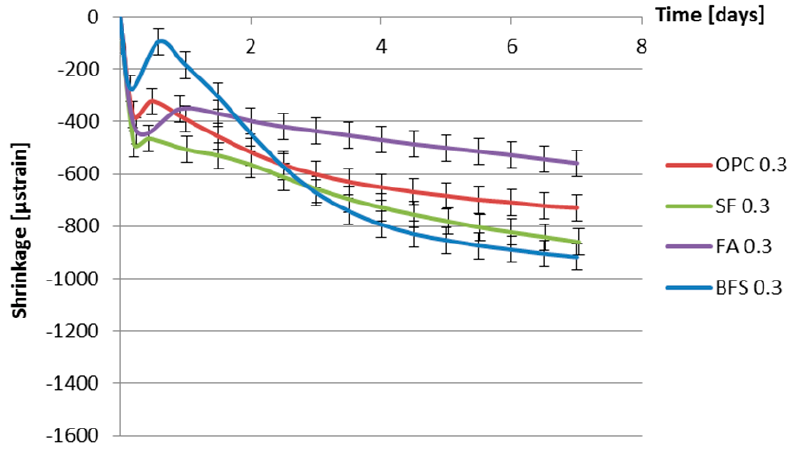
Figure 12. Autogenous deformation vs. age for different cement pastes with water–binder ratio of 0.3 (starting time: final setting time).